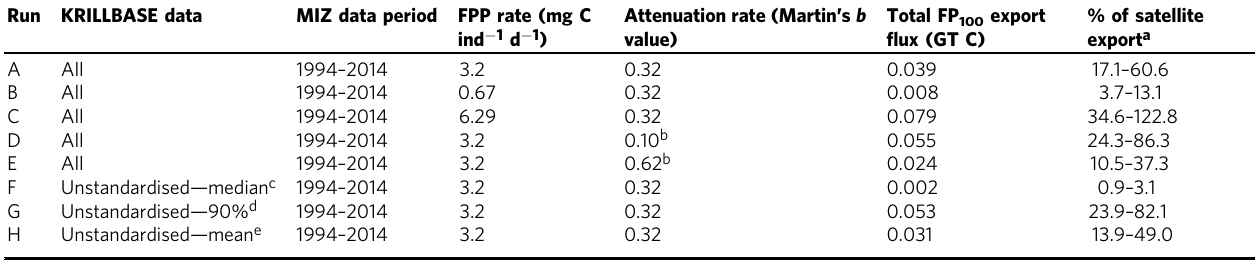
Table 2 Estimated FP export fl ux at 100 m for various sensitivity runs for the period October – March Run KRILLBASE